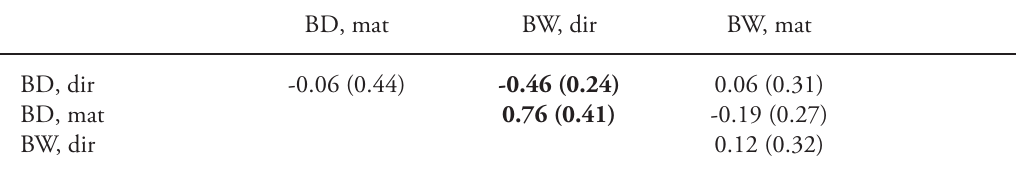
Table 5. Estimates of direct (dir) and maternal (mat) genetic correlations (standard errors in parentheses) of the bivariate analysis in birth date (BD) and birth weight (BW) of reindeer calves in the Kutuharju reindeer herd in